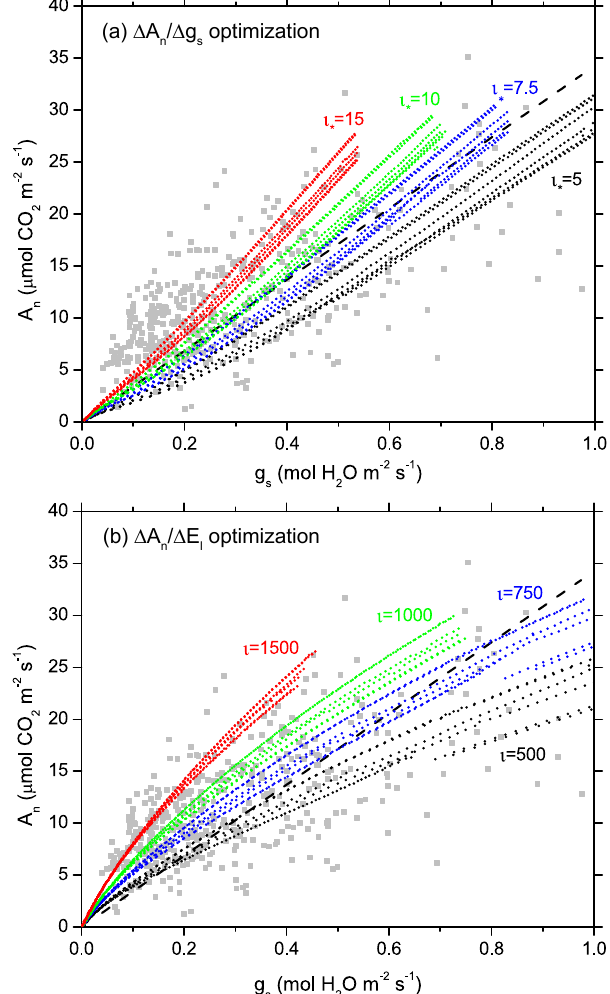
Figure 5. Observed and simulated relationships between A n and g s . Observations (light grey symbols) are from the Glopnet leaf trait database (Wright et al., 2004) for C 3 plants ( n = 421). The dashed line shows the best-fit regression equation, A n = 34 . 3 g s . Simulations show optimal A n and g s calculated for 100 theoretical leaves that differed in photosynthetic capacity, specified by varying V cmax25 from 1.5–150µmolm − 2 s − 1 . (a) SPA-iWUE optimiza- tion simulations with ι ∗ = 5, 7.5, 10, and 15µmolCO 2 mol − 1 H 2 O. (b) SPA-WUE optimization simulations with ι = 500, 750, 1000, and 1500µmolCO 2 mol − 1 H 2 O. The model simulations used six different meteorological forcings, producing six different A n – g s re- lationships for each value of stomatal